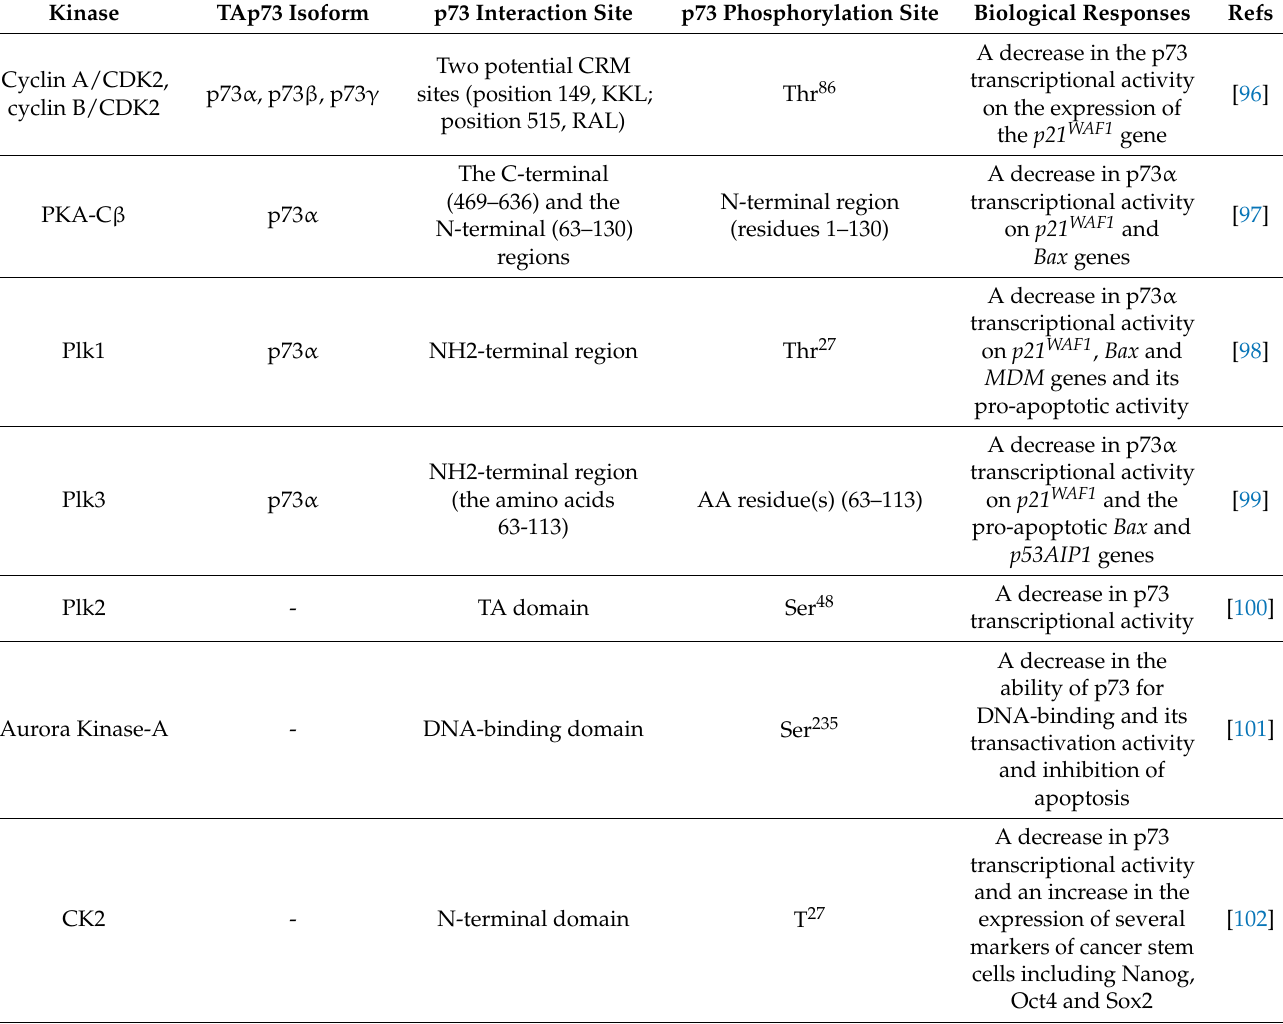
Table 2. Role of kinases in p73